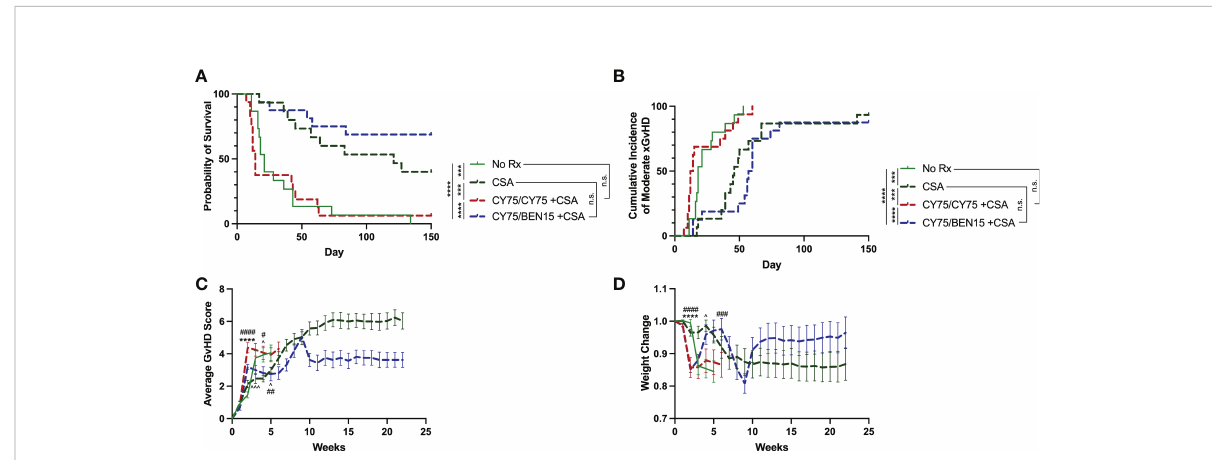
FIGURE 2 Survival from xGvHD is improved with combination CY/BEN +CSA. Animals received no pharmacological treatment (no Rx, n=15), or were treated with 10mg/kg daily cyclosporine A (CSA) for two weeks starting at day +5 and then 3x/week for the remainder of the study either alone (CSA, n=15), or in combination with post-PBMC infusion chemotherapy agents, 75mg/kg CY on days +3 and +4 (CY75/CY75 +CSA, n=16), or 75mg/kg CY on day +3 and 15mg/kg BEN on day +4 (CY75/BEN15 +CSA, n=16). (A) Kaplan-Meier survival curve illustrating differences in survival between groups. (B) Cumulative incidence of moderate xGvHD are depicted. (A, B) The Log-rank Mantel-Cox test for survival/incidence curves was used to assess statistical differences, with p values indicated by the number of asterisks between groups: ***<0.001, ****<0.0001, n.s.= not signi fi cant. (C) Average GvHD scores over time. (D) Changes in weight over time. (C, D) Statistics were run using a two-way ANOVA followed by S ̌ ı ́ da ́ k ’ s multiple comparisons. P values are indicated by the number of symbols between groups noted on graphs *<0.05, **<0.01, ***<0.001, ****<0.0001. Arrows (^) indicate differences between no Rx and CSA. Asterisks (*) indicate differences between no Rx and CY75/ CY75 +CSA. Pound symbols (#) indicate differences between no Rx and CY75/BEN15 +CSA. (A-D) Data are combined from 3 independent experiments using different blood donors for PBMC infusion with 15-16 mice total per